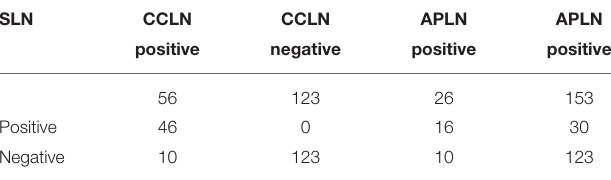
TABLE 4 | Status of SLN, CCLN, and